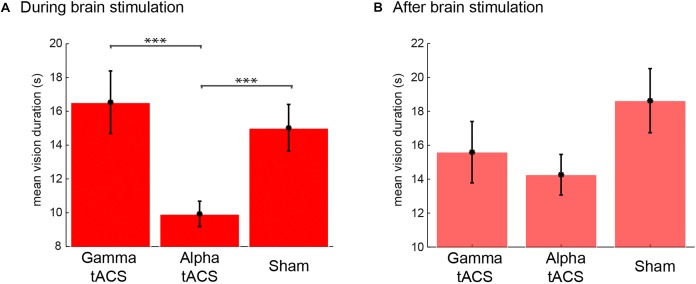
Duration of visual imagery events during and after tACS brain stimulation and sham. Mean vision duration (s) during (A) and after (B) tACS in gamma and alpha frequency and sham.